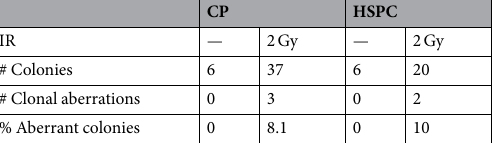
Table 1. Clonal chromosomal aberrations in the progeny of individual HSPC and CP. Full karyotype analysis for each colony can be found in Supplementary table 1. Table 1 presents summary of three independent sorting and karyotyping experiments using cord blood preparations from separate donors. 1 Clonal chromosomal aberration frequency (%) was calculated by dividing the number of colonies that carried stable aberration by the total number of colonies analyzed from the same group 2 Representative metaphases for each group can be found in Supplementary Figure